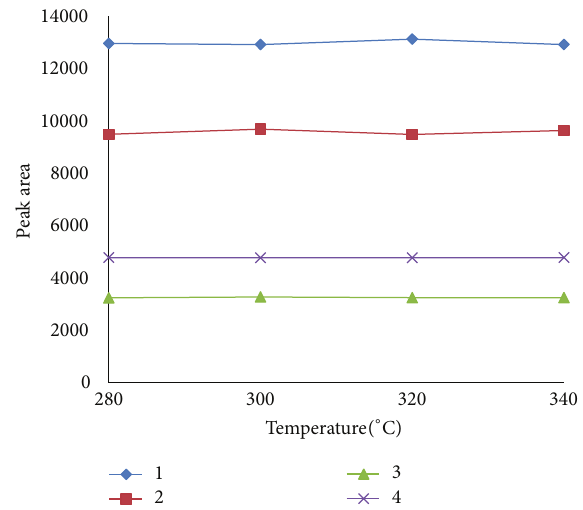
Figure 1: Thermal stability of MWNTs-TSO-OH fiber. Conditions: extraction time, 30 min; extraction temperature, 70 ∘ C; and desorp- tion time, 5min. Peaks: 1, n C 17 -alkane; 2, pristine; 3, naphthalene; and 4, 5- 𝛼 -Androstane. Table 1: Preparation reproducibility of MWNTs-TSO-OH fibers with 70 𝜇 m